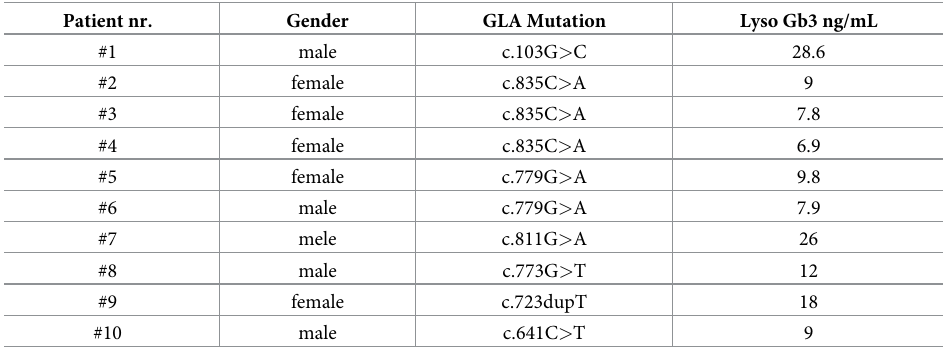
Plasma Lyso Gb3 normal levels are: (cid:20) 1.8